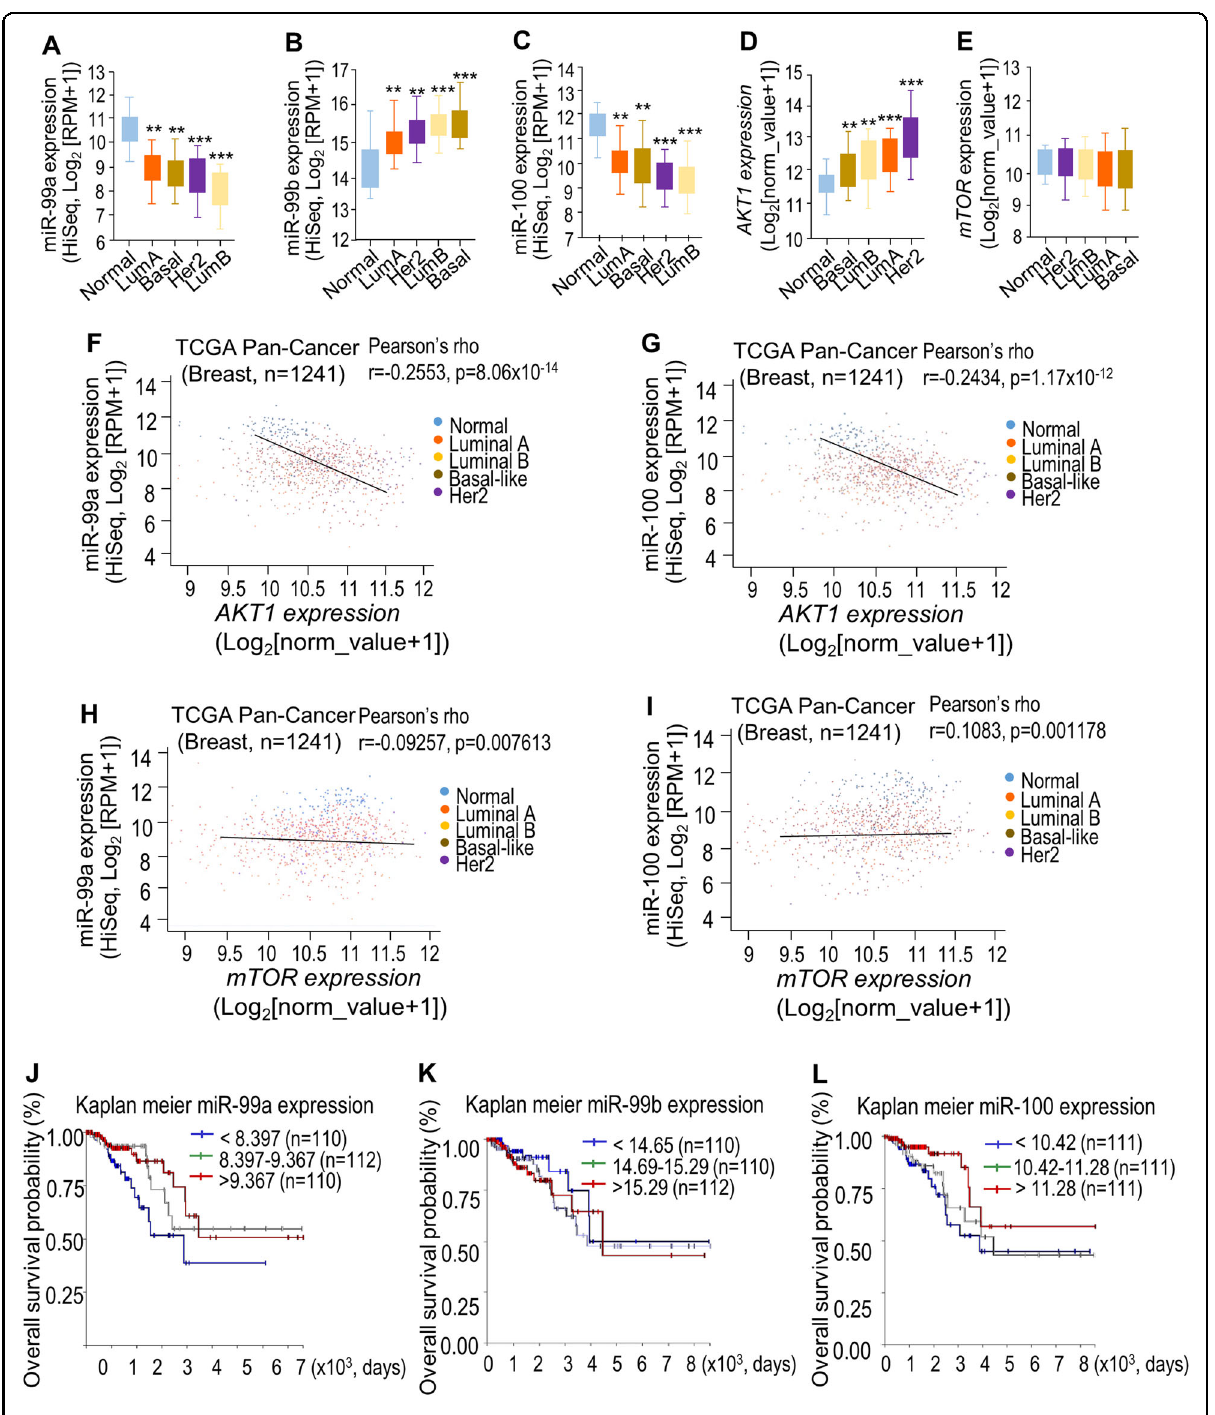
Fig. 3 miR-99s and AKT1/mTOR expressions in breast cancer samples. a – e RNA-seq data for expression of miR-99s ( a – c ), AKT1 ( d ), and mTOR ( e ) in the indicated subtype in The Cancer Genome Atlas (TCGA) database. Expression of AKT1 is negatively associated with the expression of miR-99a ( f ) and miR-100 ( g ) in breast cancer tissues in the TCGA PAN-CANCER breast database. The correlation between mTOR and miR-99a ( h ) or miR-100 ( i ). j – l Overall survival in patients with breast cancer strati fi ed according to miR-99s expression status in their primary tumors. Survival time data are presented as means ± SEM. The log-rank test P value re fl ects the signi fi cance of the correlation between miR-99s positivity and longer survival